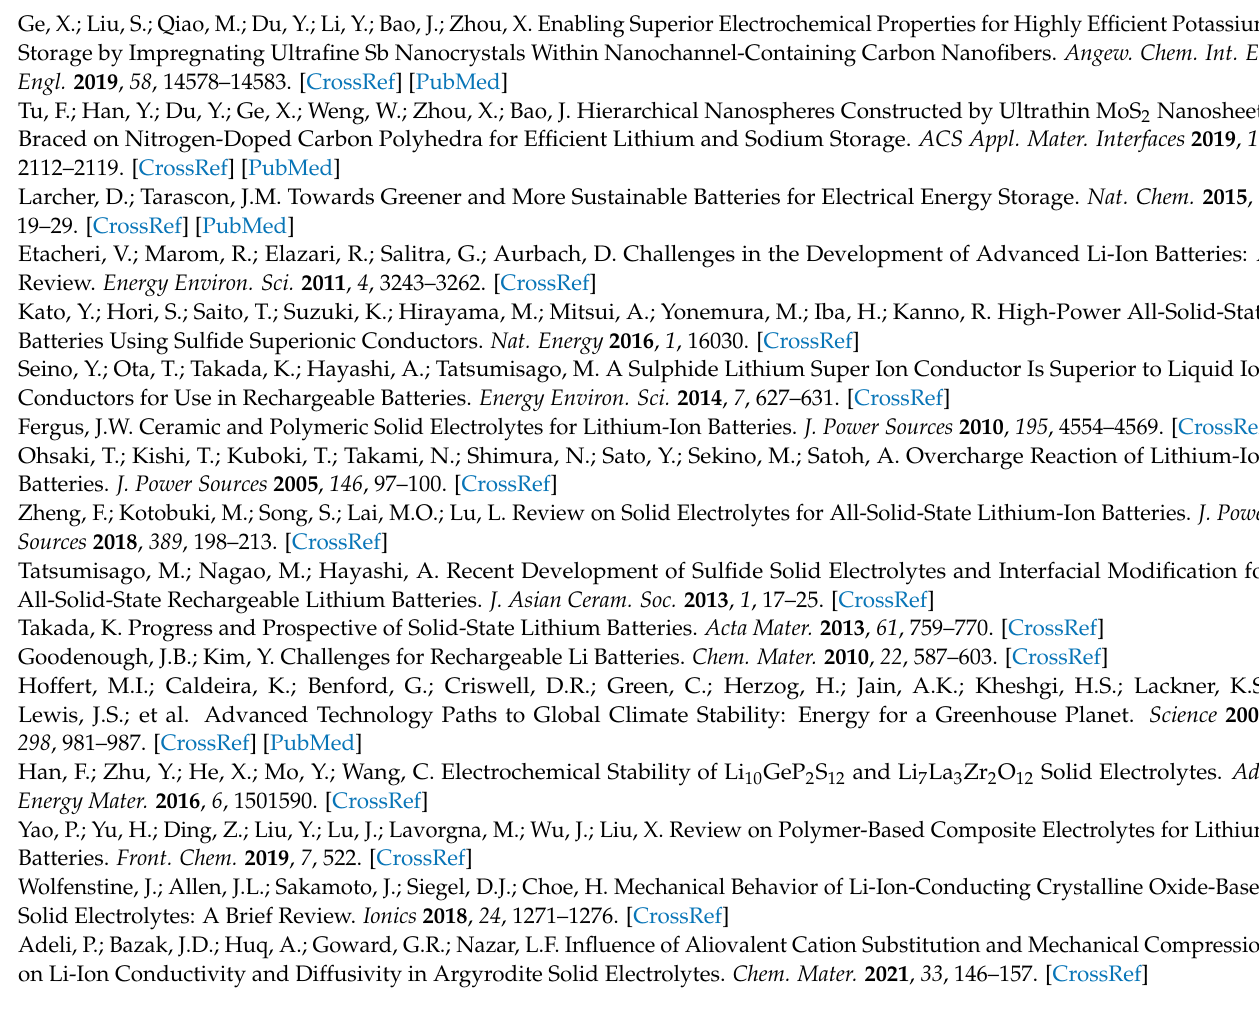
electrolytes. Figure S2: XRD pattern of and the corresponding Rietveld refinement of Li 5.4 Al 0.1 PS 4.7 Cl 1.3 electrolyte. Figure S3: XPS spectra of Li 6 PS 5 Cl, Li 5.5 PS 4.5 Cl 1.5 , Li 5.55 Al 0.15 PS 5 Cl, and Li 5.4 Al 0.1 PS 4.7 Cl 1.3 electrolytes for (a) Survey, and (b) Li 1s. Figure S4: (a) Schematic diagram of cell geometry for impedance measurement. (b) Equivalent circuit for modeling the EIS data. Nyquist plots of (c) Li 6 PS 5 Cl, (d) Li 5.5 PS 4.5 Cl 1.5 , (e) Li 5.55 Al 0.15 PS 5 Cl, and (f) Li 5.4 Al 0.1 PS 4.7 Cl 1.3 electrolytes, respec- tively. Experimental data (circles) was fitted with the simulated data from equivalent circuit modeling (lines). Figure S5: Nyquist plots of the (a) Li 6 PS 5 Cl, (b) Li 5.5 PS 4.5 Cl 1.5 , (c) Li 5.55 Al 0.15 PS 5 Cl, and (d) Li 5.4 Al 0.1 PS 4.7 Cl 1.3 electrolytes measured from 25 to 100 ◦ C, respectively.; Table S1: Rietveld refinements data of Li 5.4 Al 0.1 PS 4.7 Cl 1.3